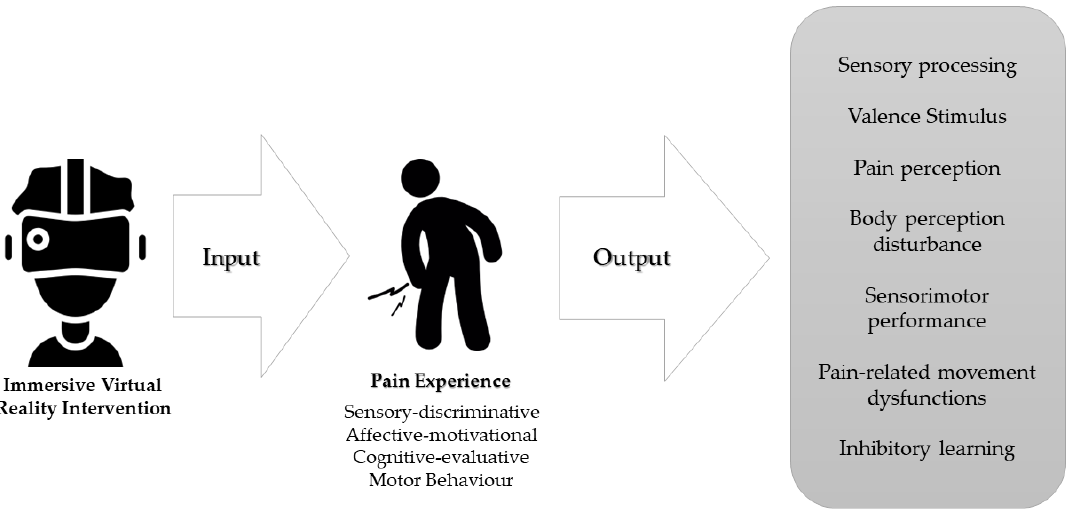
Figure 2. Therapeutic targets of immersive virtual reality intervention according to the distinct dimensions of the experience of chronic pain.